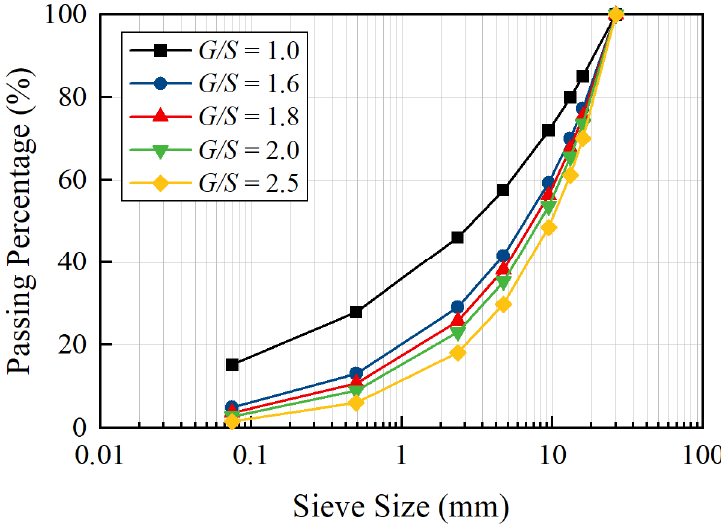
Figure 2. Gradation curves of unbound aggregate base materials tested. Table 1. The designed gradation and related parameters.